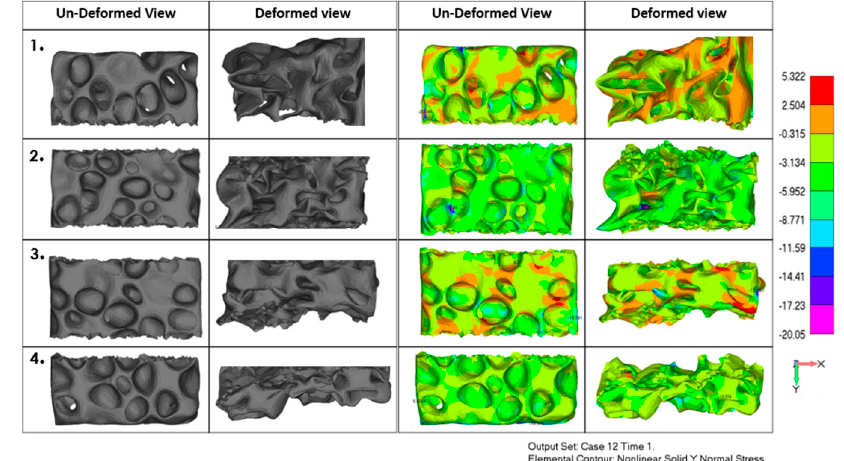
Figure 9. Numerical model in finite element analysis (FEA) in loading direction: Un-deformed view and deformed view. The two columns on the left show the geometrical model of the numerical sample; the two columns on the right show stress contour in loading (y-axis) direction.